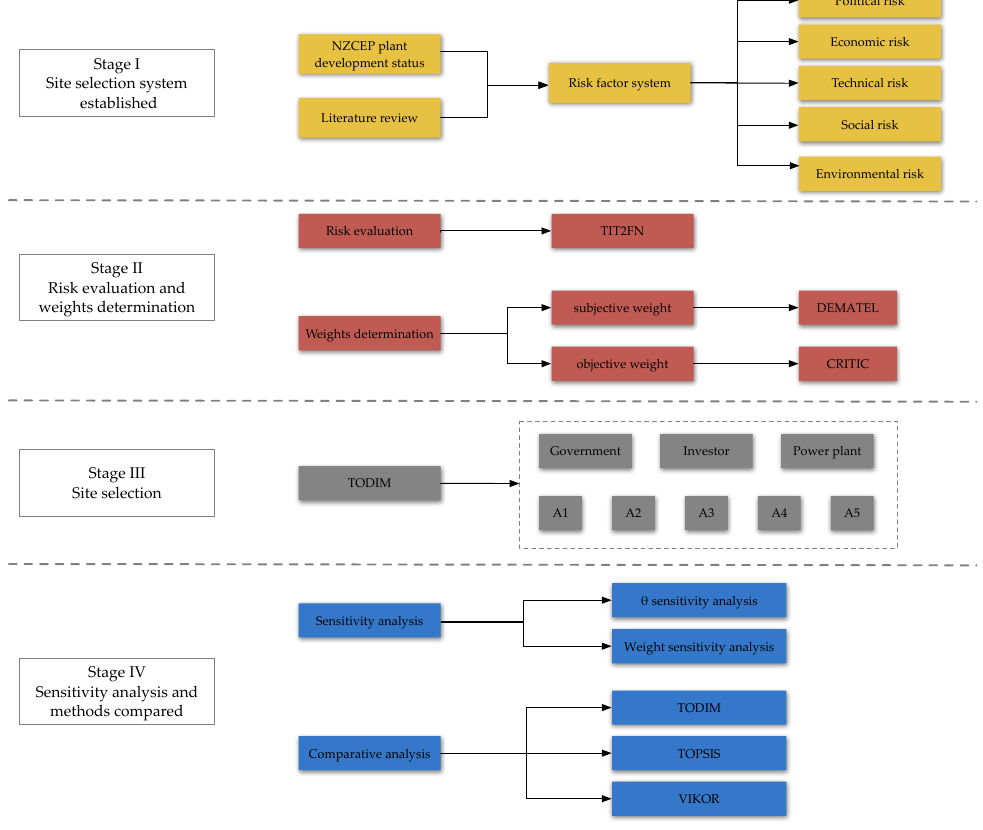
Figure 3. Study framework of NZCEP optimal selection.